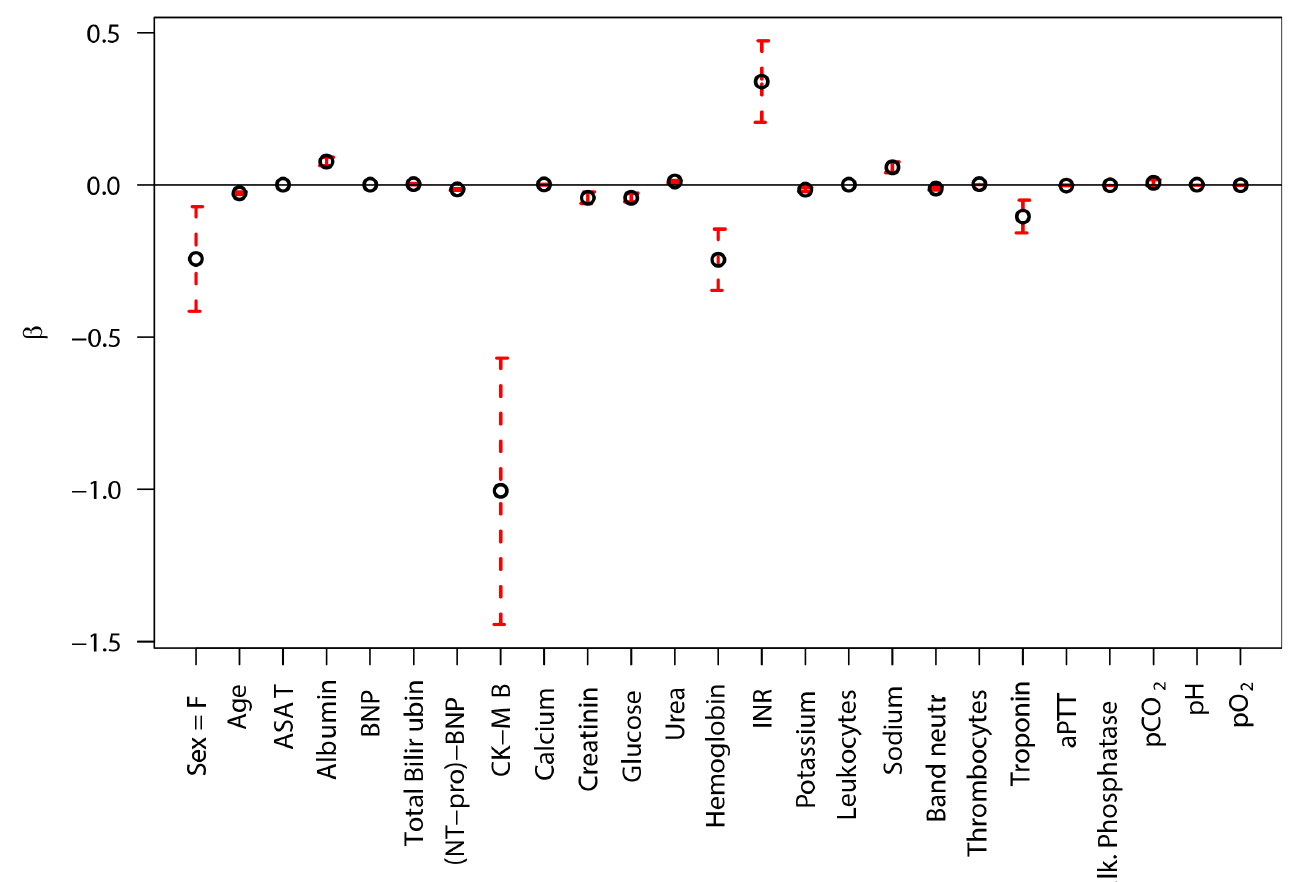
Fig 3. Absolute values of model parameters, along with 95% confidence intervals, for the GLM.